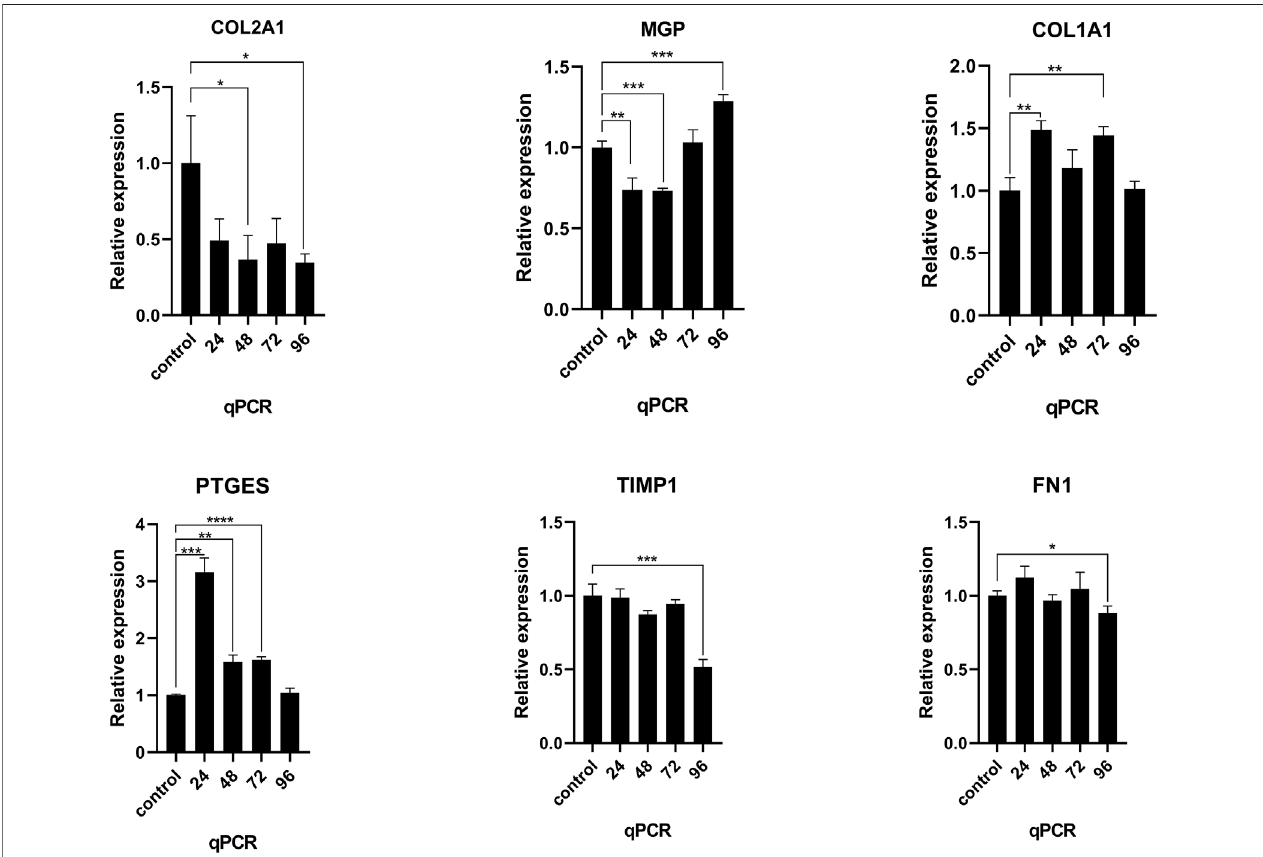
FIGURE 6 | RT-qPCR was used to detect the mRNA expression of COL2A1, MGP, COL1A1, PTGES, TIMP1, and FN1 in human NNP cells treated with TNF α for different time periods. * p < 0.05, * p < 0.01, * p < 0.001, * p < 0.0001.